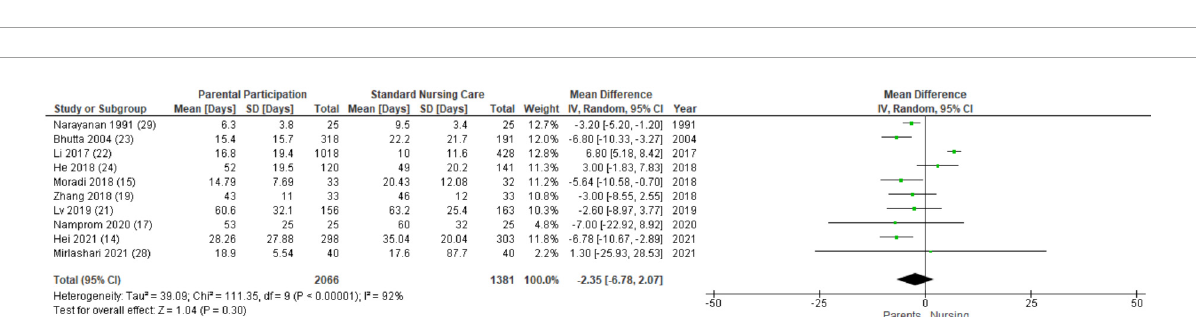
FIGURE1 PRISMA flow diagram.